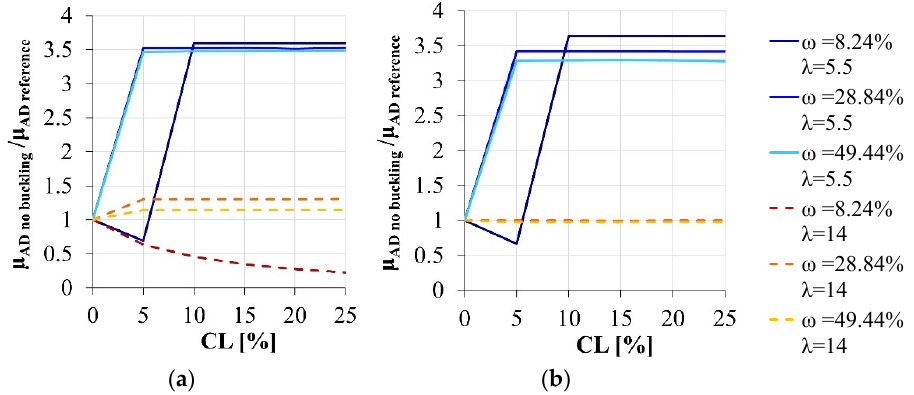
Figure 8. Local ductility variation due to the corrosion degradation: comparison between the simplified model disregarding the buckling effects and the reference section. ( a ) ν = 25.65%, ( b ) ν = 15.39%.